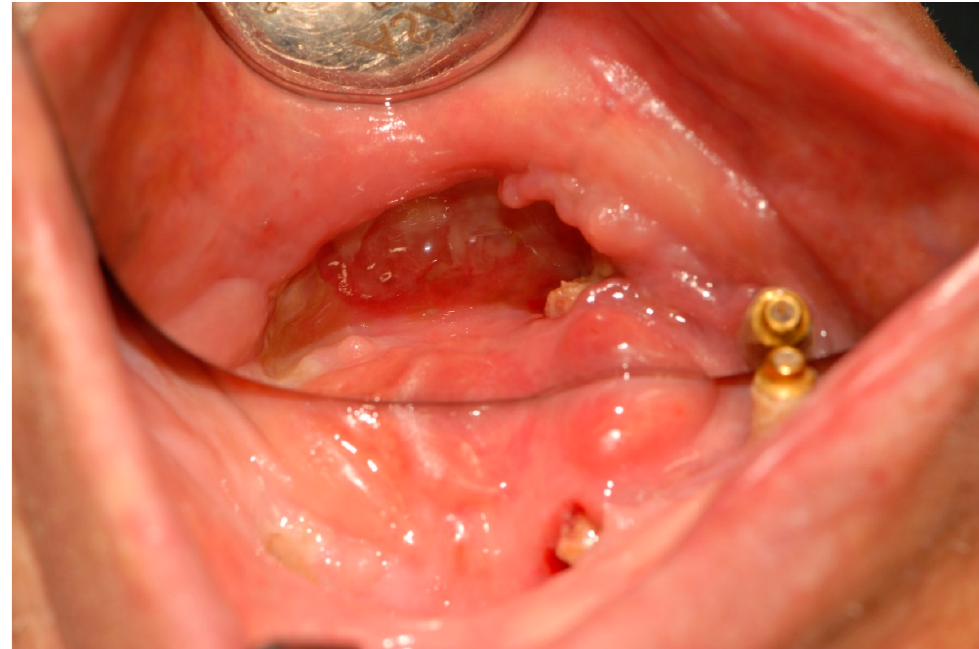
Figure 4. Clinical aspect of the patient after the detachment of the necrotic bone fragment.